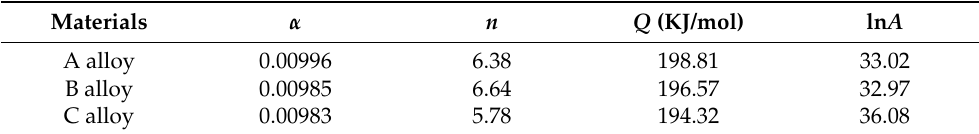
Table 4. The fixed coefficients of three alloys with strain rate of 1.0.